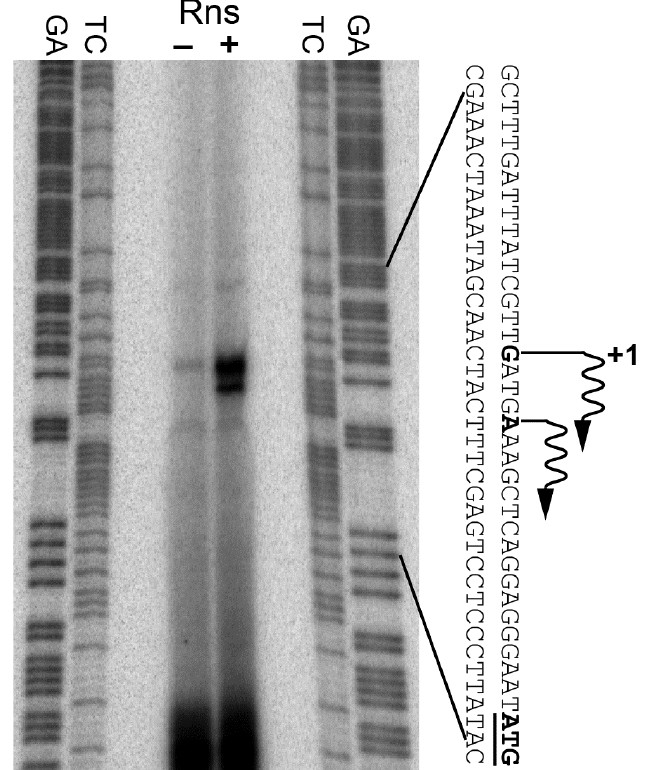
Figure 1. Identification of the Rns-dependent transcription start site. The transcription start site of the CS14 pilus promoter was mapped by primer extension of mRNA isolated from rns + and rns::kan strains. Transcription start sites and the start codons of csuB are shown in bold. Wavy arrows indicate the direction of transcription. Lanes labeled GA and TC contain Maxam-Gilbert sequencing ladders.